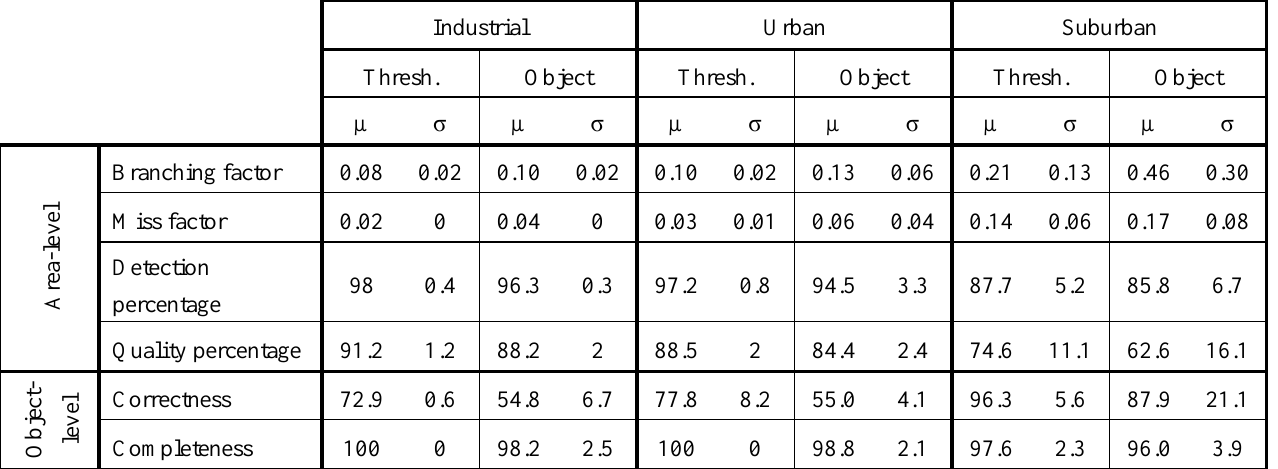
Table 5. Comparison of mean (µ) and standard deviation (σ) of building detection metrics for the thresholding-based (Thresh) and object-based classification (Object). Industrial Urban Suburban Thresh. Object Thresh. Object